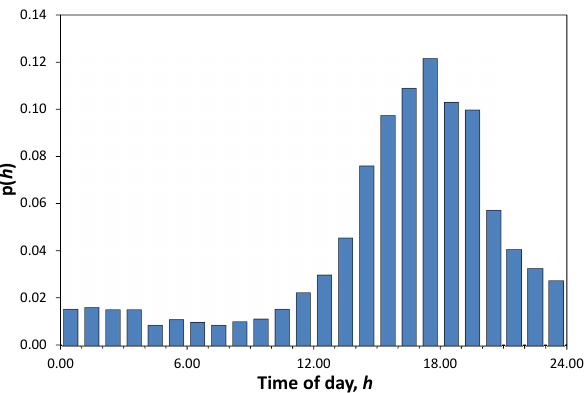
Fig. 4. Histogram of the distribution of continental USA severe tor- nadoes ( L ≥ 10km) as a function of the hour of the day, h (Central Standard Time). The probabilities p( h ) of a severe tornado occur- ring are given as a function of h for the time period 1982–2011. Tornado time of day data are from NOAA (2012).